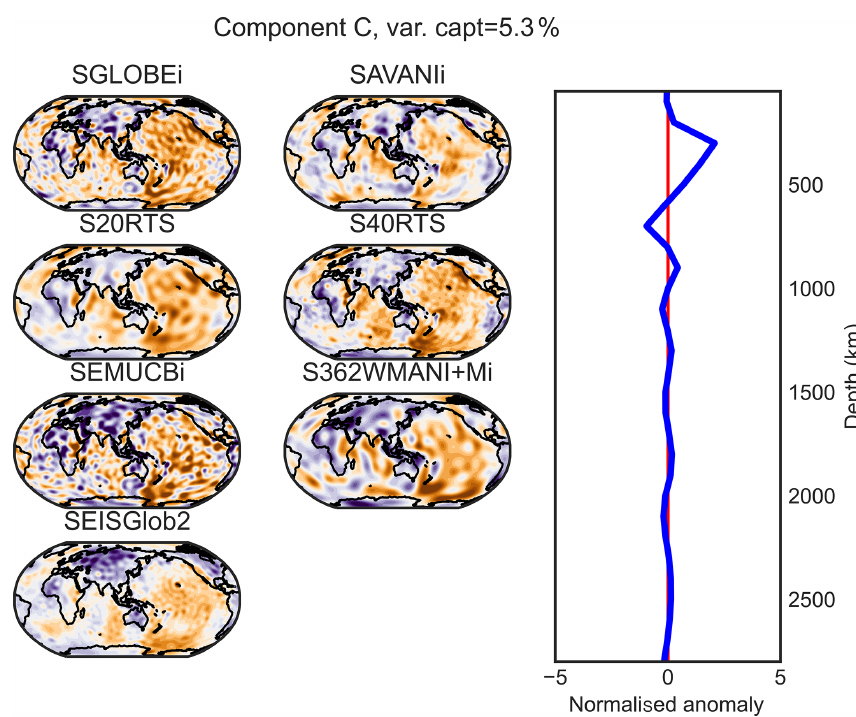
Figure D3. PC C (maximum at 300km of depth) of the combined analysis of the isotropic parts of the models.